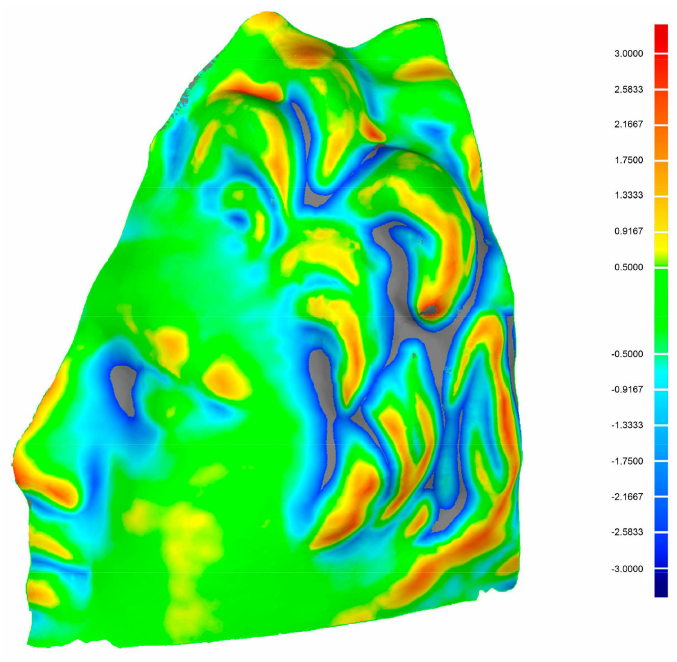
Figure 16. Comparison between the first photogrammetric model and the laser-scanning model.